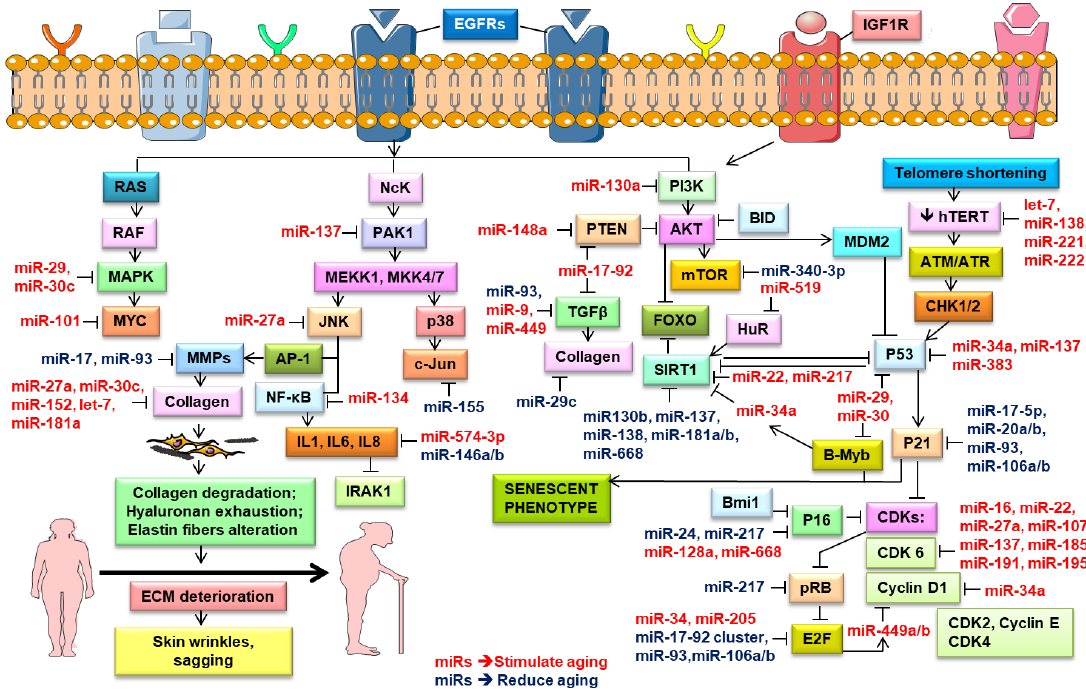
Figure 3. Role of microRNA in the regulation of the key molecular signaling pathways in the skin aging process. Schematic diagram shows the miRNAs that regulate cellular signaling mechanisms and potentially stimulate (depicted in red color) and reduce (represented in blue color) aging. Pointed arrow defines activation, while blunted – inhibition. This figure was created using images from